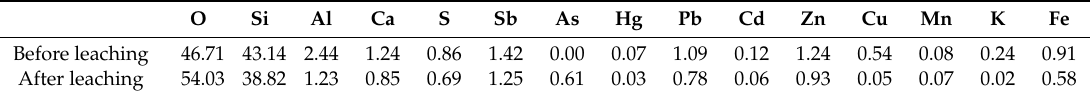
Table 3. Main elements of antimony ore waste rocks surface at different periods by EDS (%, mass fraction). O Si Al Ca S Sb As Hg Pb Cd Zn Cu Mn K Fe Before leaching 46.71 43.14